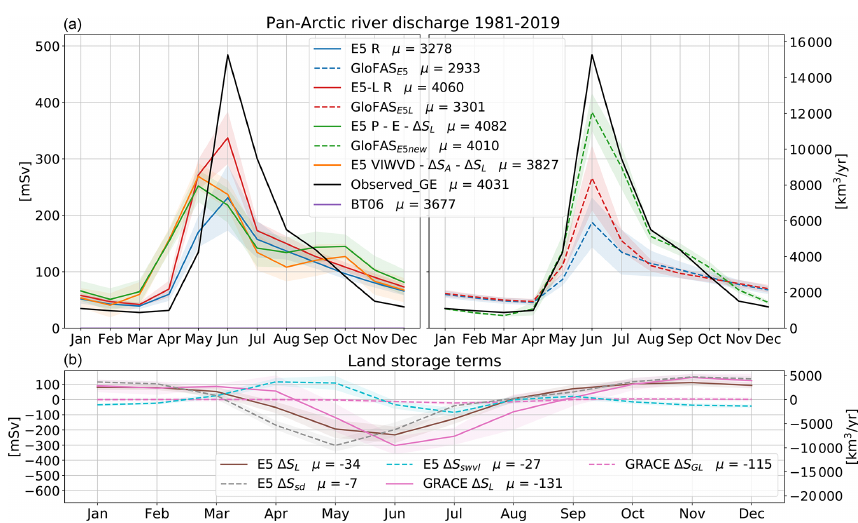
Figure 5. (a) Seasonal cycles of pan-Arctic runoff for ERA5, ERA5-Land, and various GloFAS versions as well as indirectly calculated runoff through P − E and VIWVD. Additionally, an estimate of observed river discharge is given. Seasonal cycles are calculated over the period 1981–2019 (1999–2018 for GLOFAS E5L ). (b) Storage change components from GRACE and ERA5. ERA5 snow depth (dashed brown) and soil water change (dashed cyan) sum up to the total ERA5 storage change (solid brown). Shading denotes variance as ± 1SD (1 standard deviation). Furthermore, long-term annual means in km 3 yr − 1 are given, and appropriately the right axis is scaled in km 3 yr − 1